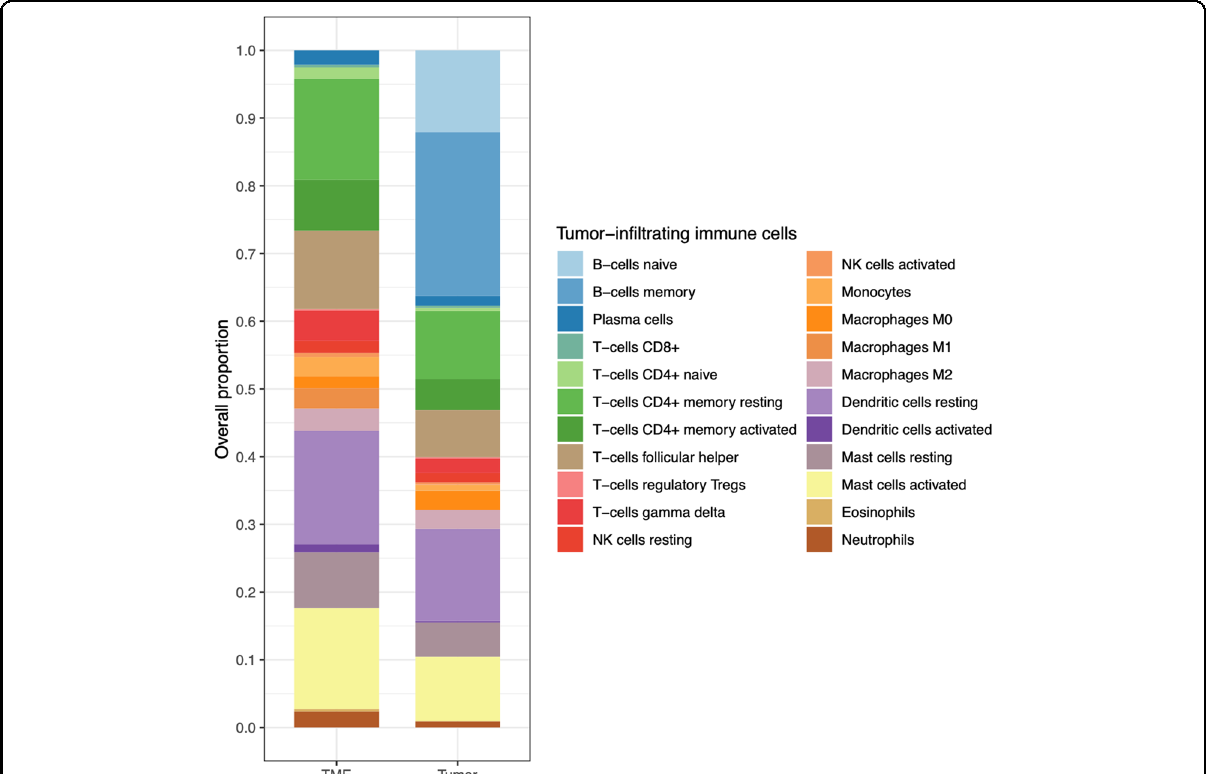
Fig. 1 TME Immune Cell Content. The overall immune cell content within the TME and